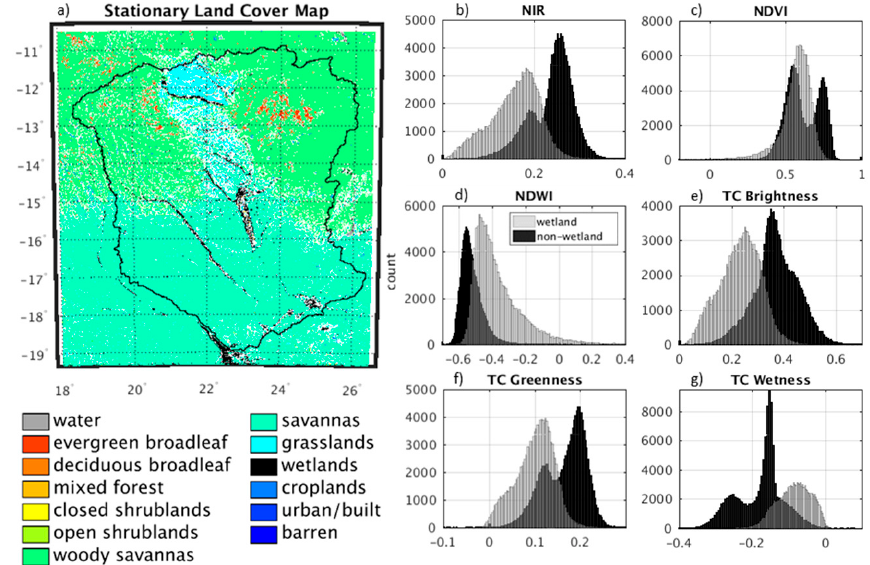
Figure 3. Stationary land cover map and histograms for unitless remote sensing indices using only the pixels representing wetland and non-wetland in the training data. Stationary land cover data and indices were derived from the MODIS MCD12Q1 and MCD43B4, respectively. ( a ) Stationary land cover map derived from MODIS MCD12Q1 data for 2010–2012. ( b – g ) Histograms for wetland and non-wetland pixels using NIR ( b ), NDVI ( c ), NDWI ( d ), TC Brightness ( e ), TC Greenness ( f ) and TC Wetness ( g ).